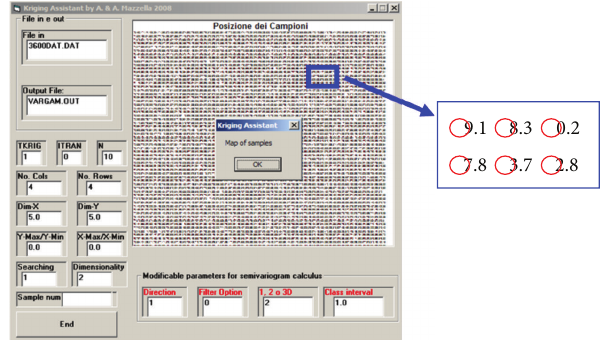
Figure 10: Geometrical extrapolation for “nugget effect” determination.